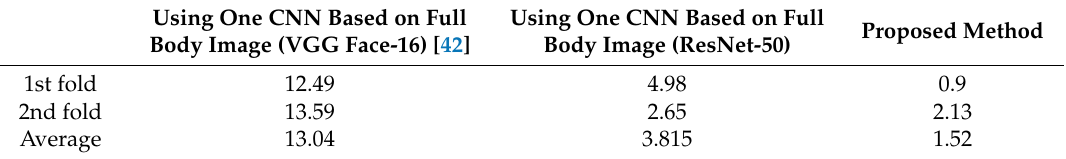
Table 9. Comparisons of EERs by proposed method and using one CNN based on full body image (unit: %). Using One CNN Based on Full